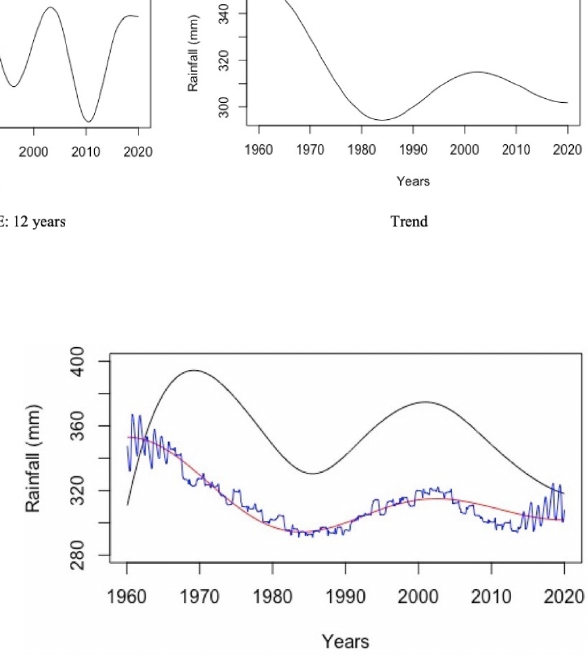
Figure 18. The residual Trend EAWD returned by the EAWD tech- nique (red curve), the trend of the original signal obtained from a moving window (blue curve) with a size fixed at 144 (i.e. 12 years), and the residual returned by the EEMD technique (black curve).